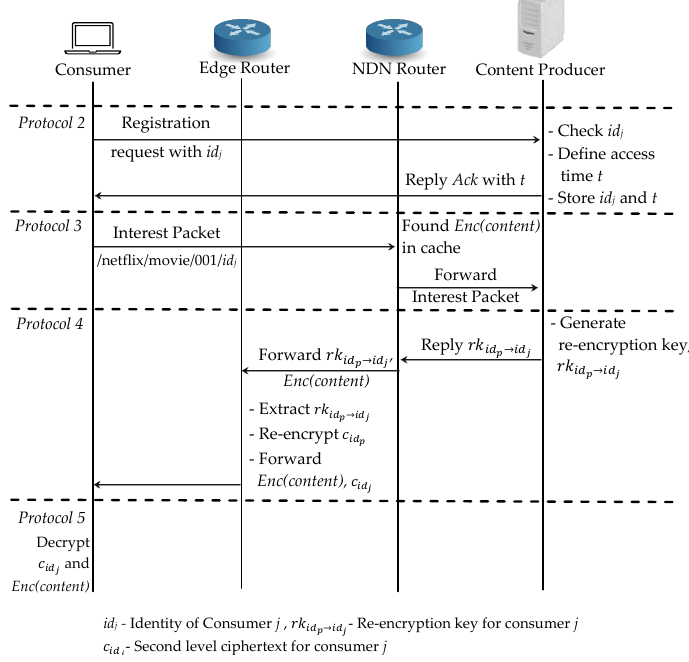
Figure 7. Proposed scheme: Case (3) a different consumer requests the same